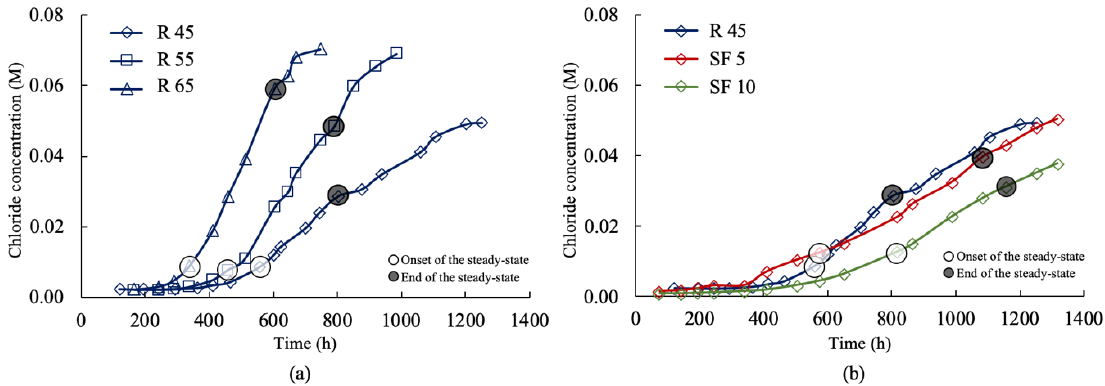
Figure 8. Evolution of chloride concentration in the anodic cell: (a) influence of the w/b ratio; (b) influence of the silica fume